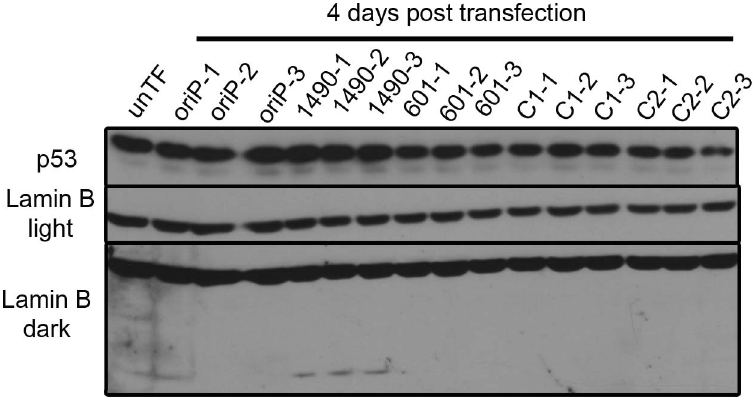
Figure 6. p53 expression is not modulated by EBNA-3A. Sal BL cells were transfected with the indicated shRNA expression vectors and harvested at 4 days post-transfection for immunoblot analysis of p53 and Lamin B. Designations light and dark refer to exposure time. The faster migrating Lamin B band is a cleavage product indicative of apoptosis.